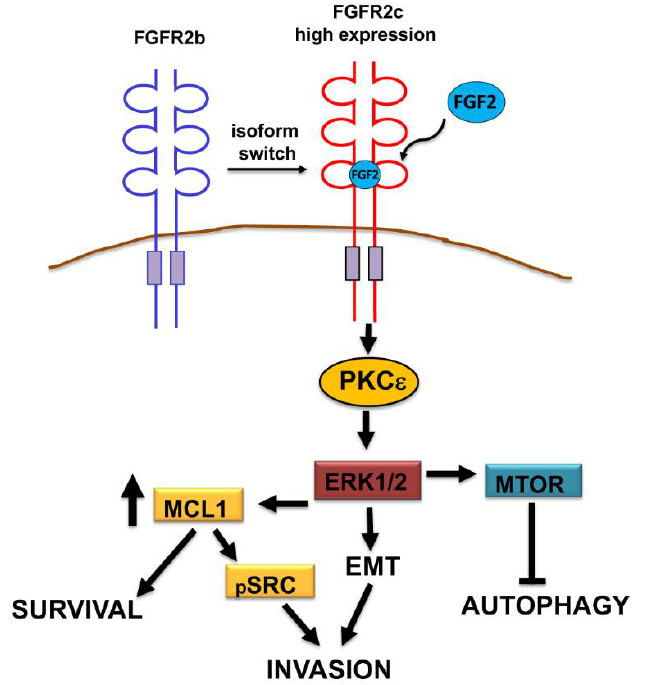
Figure 7. Schematic drawing of FGR2c/PKC ε signaling network and its tumorigenic outcomes in PDAC cells. Only when highly expressed and in response to paracrine FGF2, FGFR2c triggers the activation of the FGFR2c/PKC ε axis, which simultaneously controls, possibly converging on Extracellular Signaling-Regulated Kinase 1-2 (ERK1/2) pathway, EMT and repression of autophagy, as well as MCL-1-dependent cell survival and invasion.